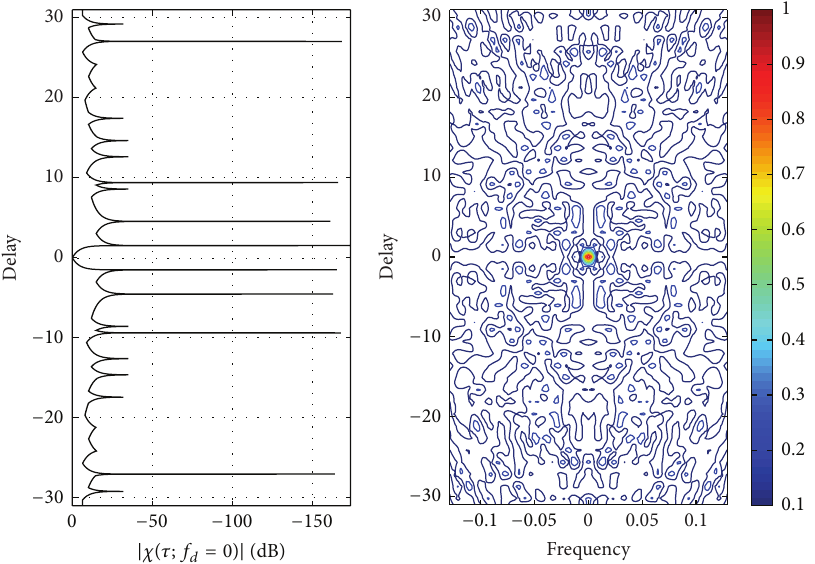
Figure 4: Ambiguity function for a 31-bit-length PRBS code: contour plot and |𝜒(𝜏;𝑓 𝑑 = 0)|